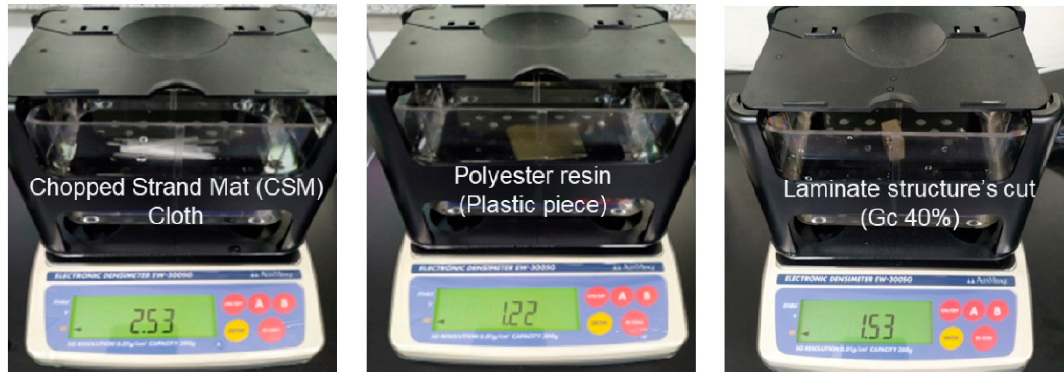
Figure 8. Measurement of the relative densities of CSM cloth, polyester, and hull plate using hydrometer. Table 6. Densities of raw materials derived from hydrometer measurements. Sample